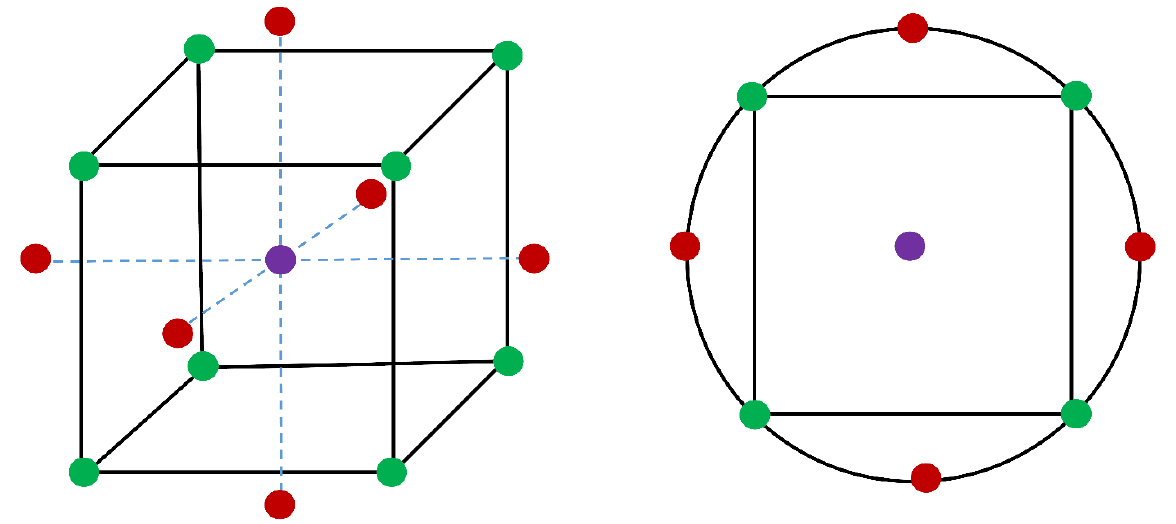
Figure 1. Schematic diagram of a central composite design-circumscribed (CCC), consisting of cube points (green), axial points (red) and central points (purple).